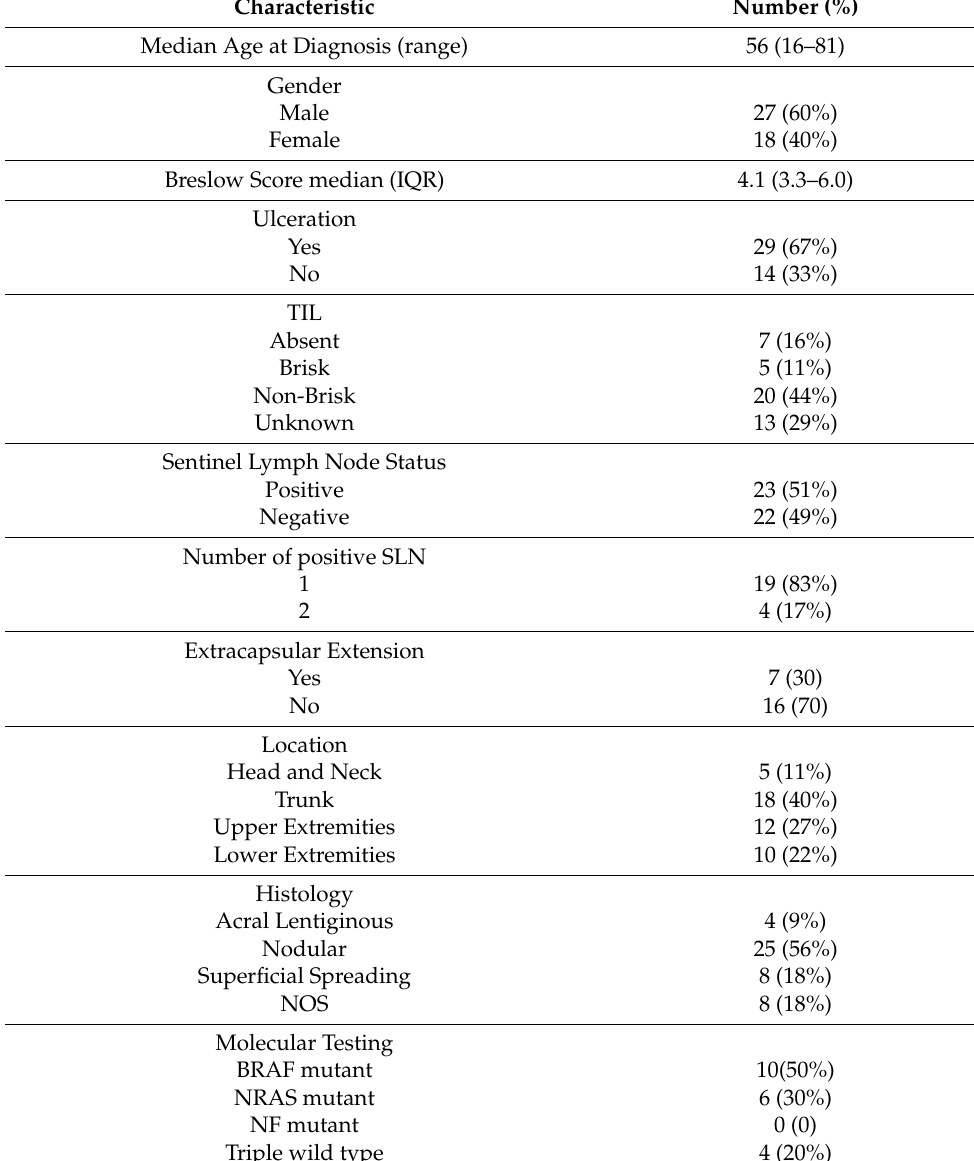
Table 1. Baseline Characteristics of Patients and